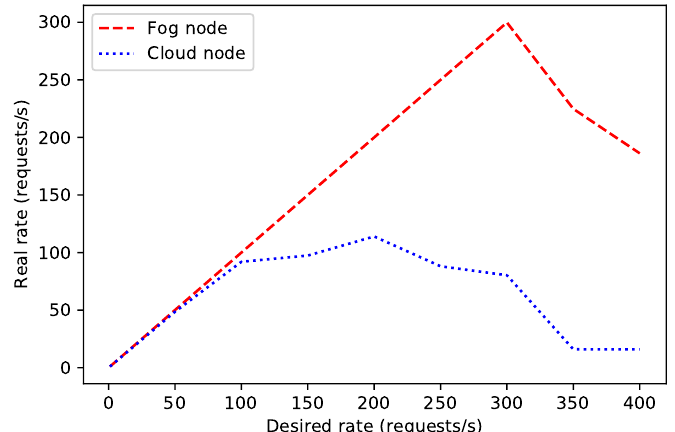
Figure 9. Desired/real request rate for 5000 connections on the fog node and 1000 on the cloud node.